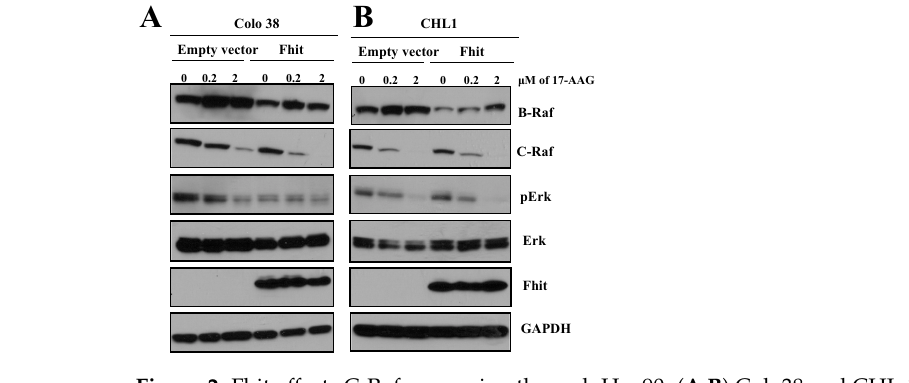
Figure 2. Fhit affects C-Raf expression through Hsp90. ( A , B ) Colo38 and CHL-1 melanoma cell lines were transfected with an empty vector or Fhit and treated with 17-AAG or DMSO at the indicated concentration for 24 hrs. Then, cell lysate was separated on SDS-PAGE gel and blotted with B-Raf, C-Raf, p-ERK, ERK, Fhit, and GAPDH antibodies.